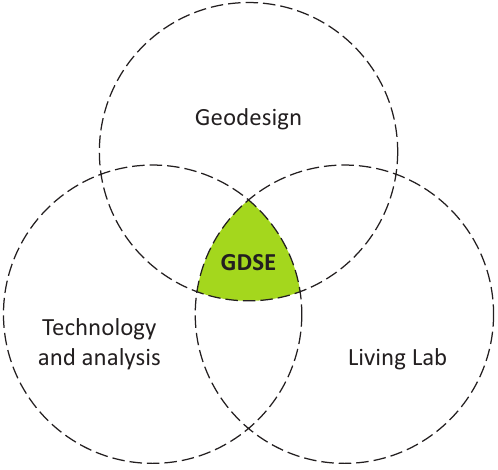
Figure 3. Integrating geodesign and living lab methodologies together with existing technology and analysis methods for the resource flow management into a single support environment, i.e., the GDSE. Source: authors. Urban Planning, 2019, Volume 4, Issue 3, Pages